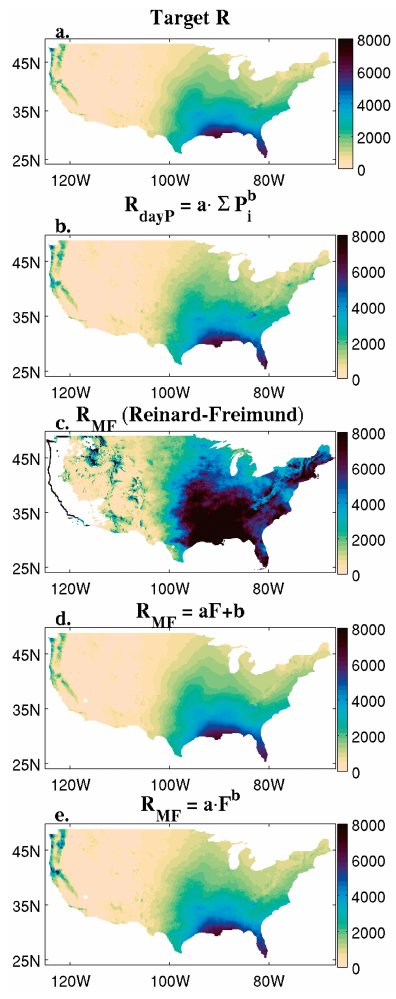
Figure 3. Overview of observational estimates of R . (a) Target ero- sivity field. (b) Erosivity calculated by regression from daily precip- P N P 365 P b itation, using the formula R = a (details in the text). n d d N (c) Erosivity calculated from annual modified Fournier index F , us- ing the published formula of Reinard and Freimund. (d) Erosivity calculated by regression from annual modified Fournier index F using the formula R = a · F + b (details in the text). (e) Same as in (d) but using the formula R = a · F b